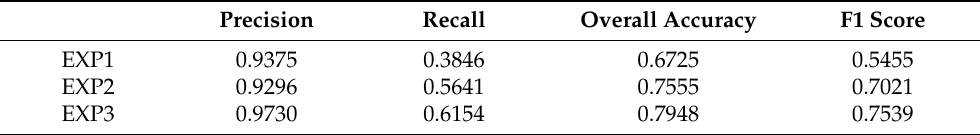
Table 6. Classification accuracy for the grassland distribution identification based on sample